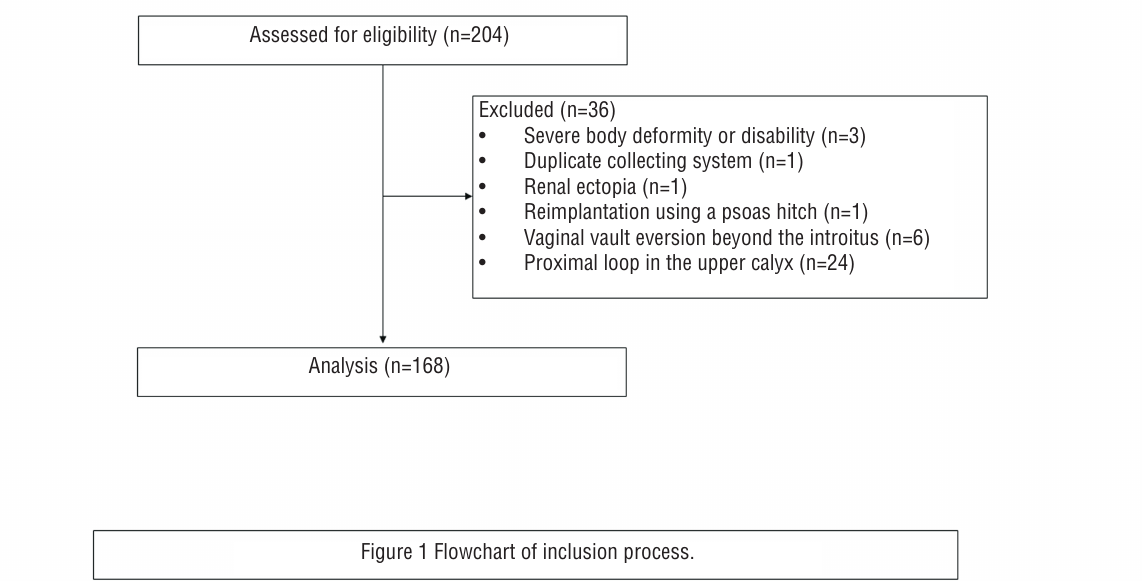
Figure 1 Flowchart of